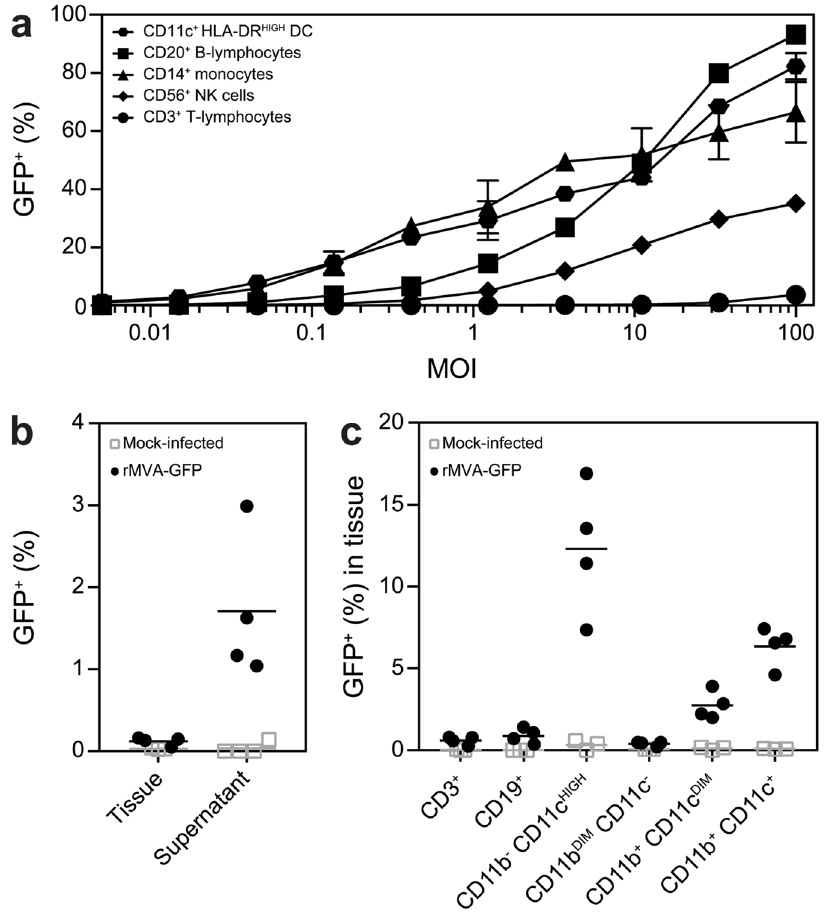
Figure 1. Populations infected by rMVA-GFP in vitro in human PBMC and ex vivo in mouse lung slices. ( a ) Human PBMC were inoculated with rMVA-GFP at various MOI. Percentage of GFP + live cells within DC, B-lymphocyte, monocyte, NK cell and T-lymphocyte populations were determined by flow cytometry at 24 h post-infection. Mean of duplicates and standard deviation are indicated. ( b ) Lung slices were inoculated with rMVA-GFP and analysed by flow cytometry after 24 h. GFP + cells in single cell suspensions of lung tissue and culture supernatant were detected. ( c ) GFP + cells in single cell suspensions of lung slices were phenotyped by flow cytometry. Populations were defined as CD3 + , CD19 + , CD11b − CD11c HIGH , CD11b DIM CD11c − , CD11b + CD11c DIM or CD11b + CD11c + . Mean percentage of infection per population of four lung slice cultures is indicated.